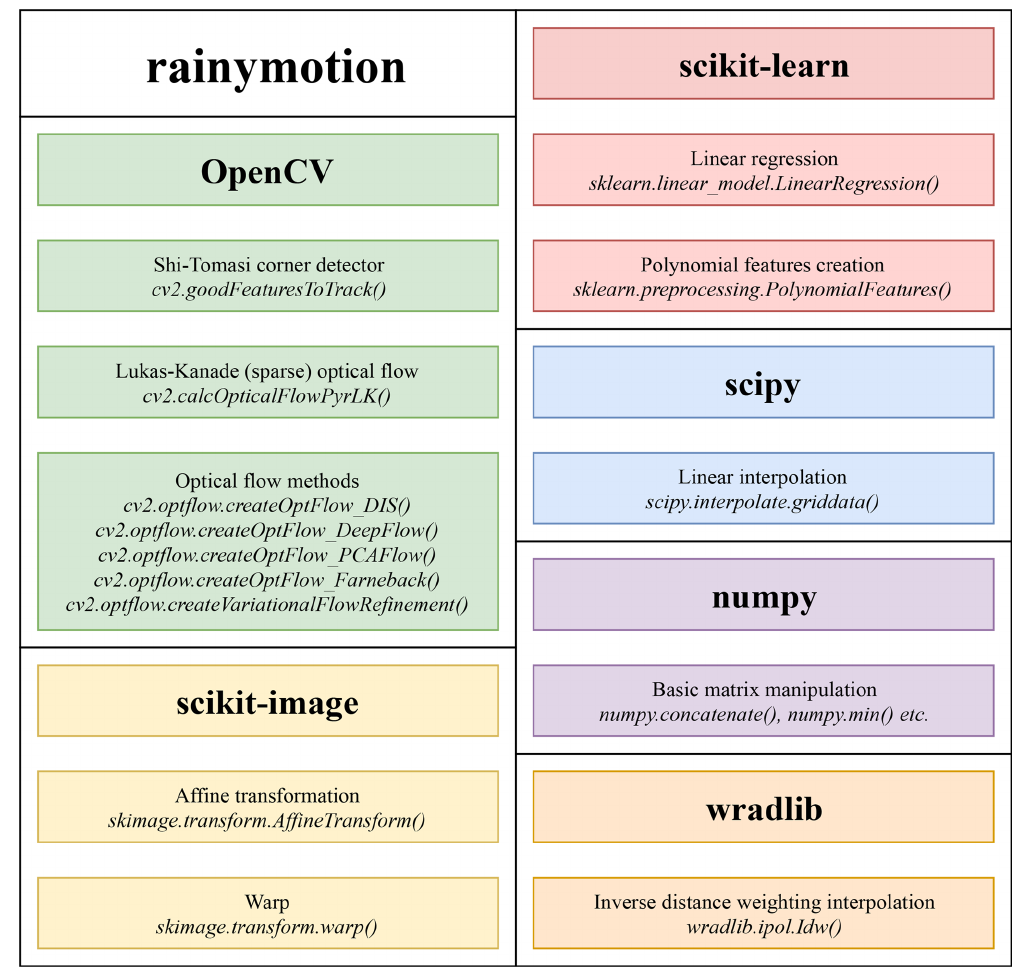
Figure 4. Key Python libraries for rainymotion library development.